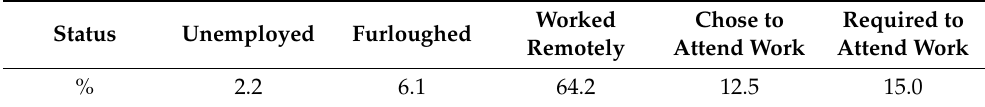
Table 6. Number of employees at respondent’s organisation (n = 314).